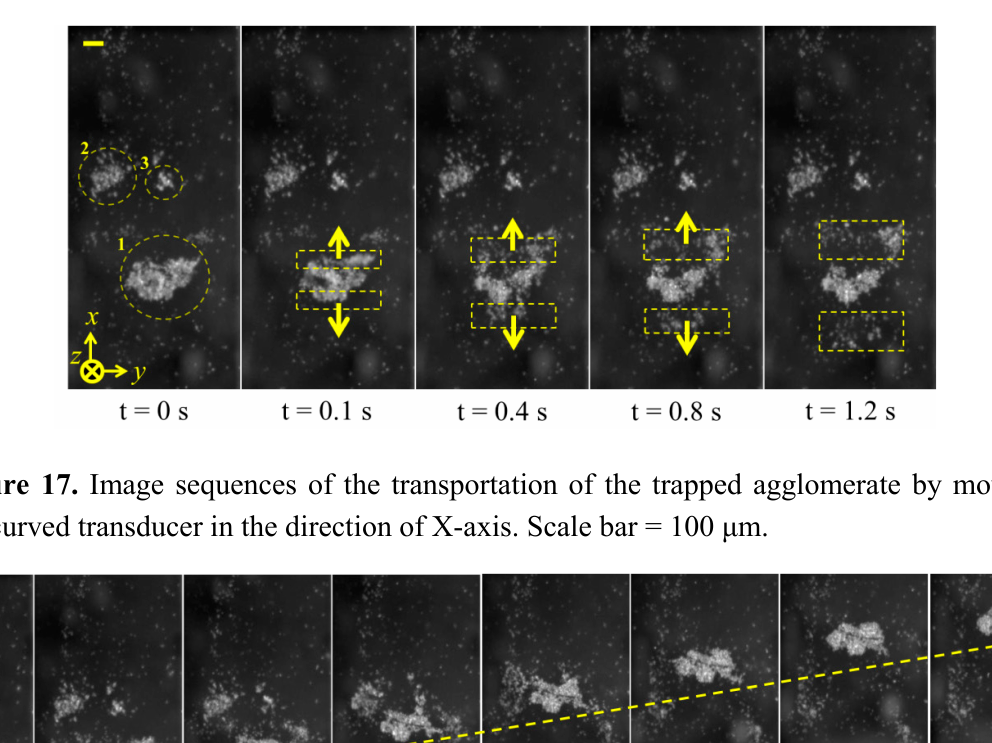
Figure 16. Image sequences of the effects of acoustic radiation forces acting on an agglomerate at the focal spot of the curved transducer. Scale bar = 100 μm.